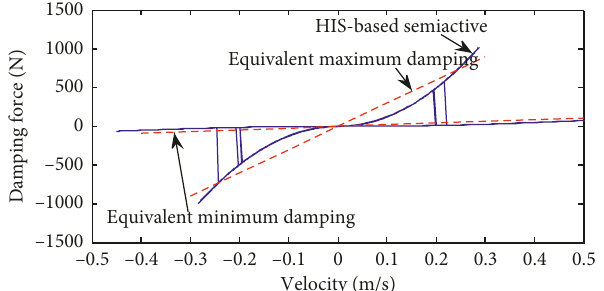
Figure 16: Damping force curves comparison between common semiactive control suspension and the proposed semiactive control